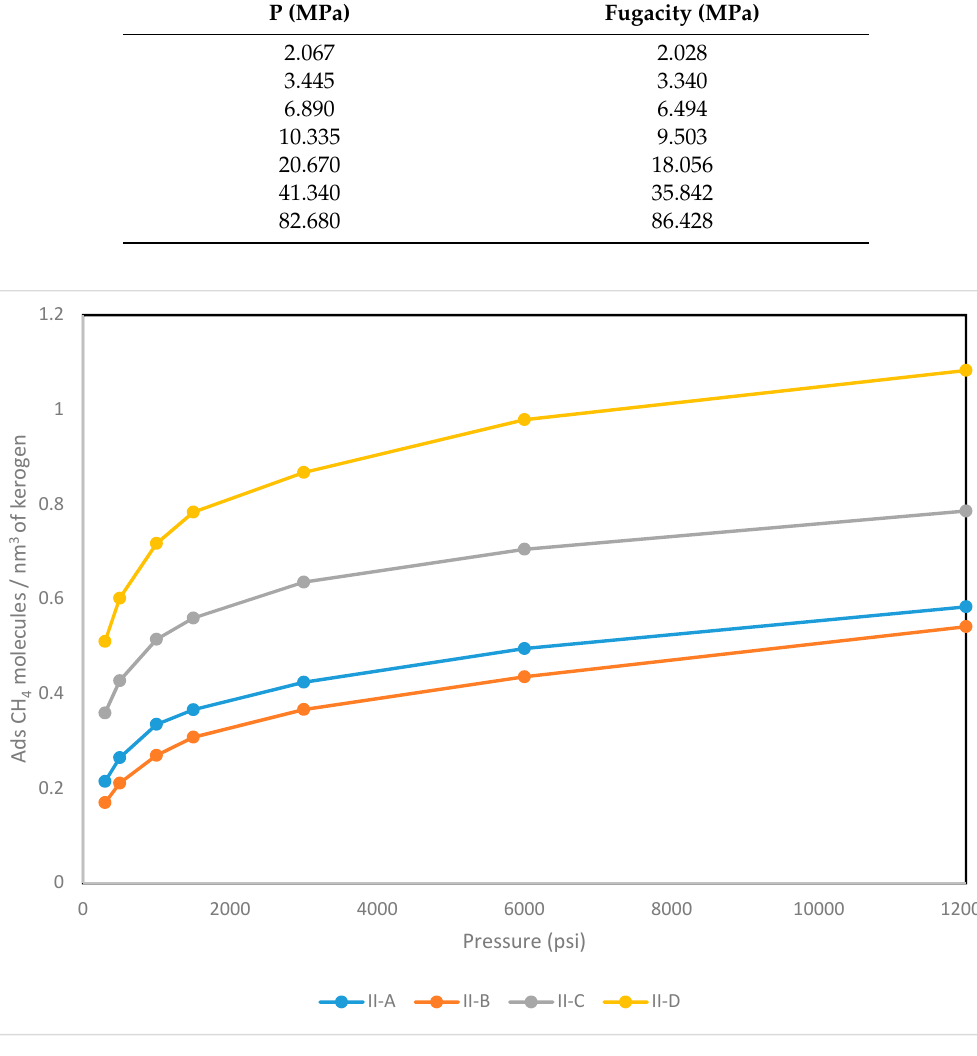
Table 3. Minerology of the three shale samples.